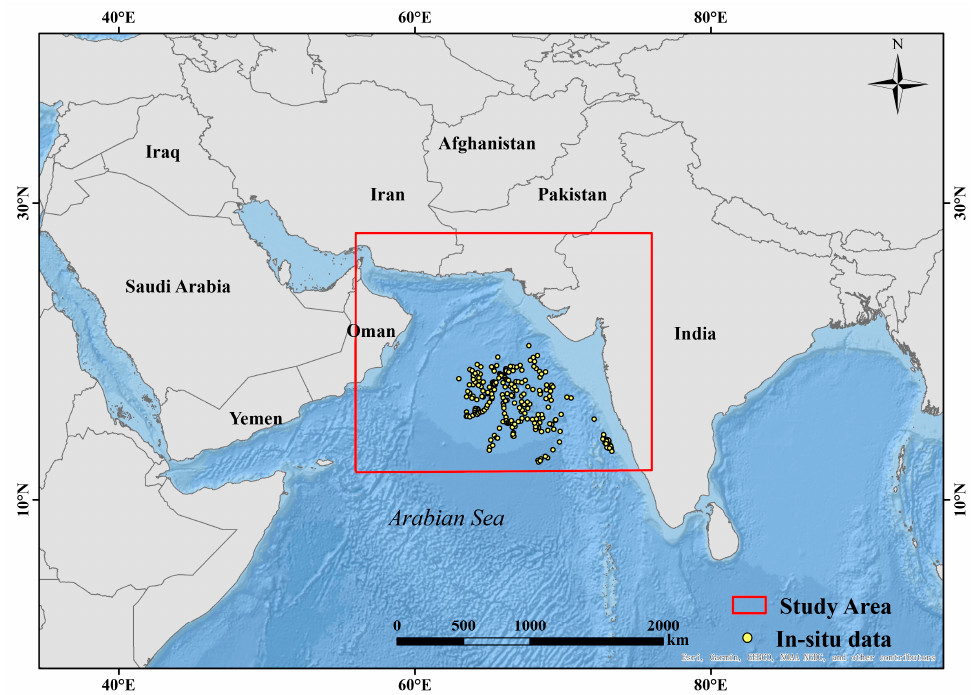
Figure 1. The red square represents the location of the NAS in the map of Asia. Yellow dots represent the locations of the in situ Chl − a measurements from the Argo data.